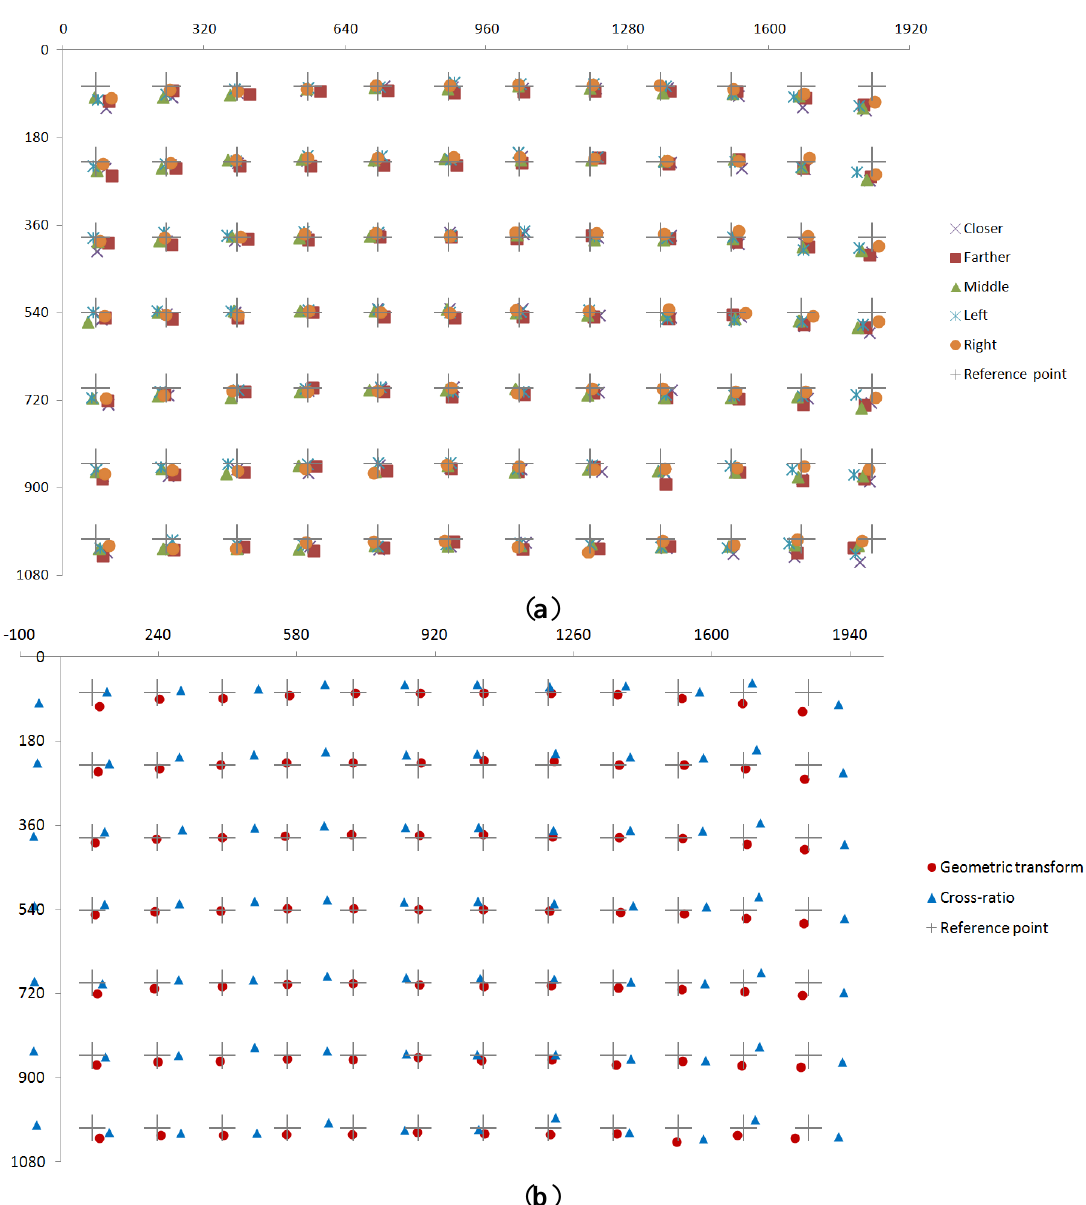
Figure 16. Results of average gaze positions of 10 users. ( a ) Average gaze positions of 10 users according to five sitting positions. ( b ) Average gaze positions of 10 users in case of geometric transform and cross-ratio methods,